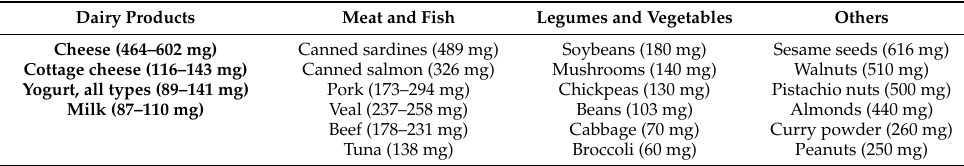
Table 3. Foods with high phosphate content (phosphate content per 100 g serving).